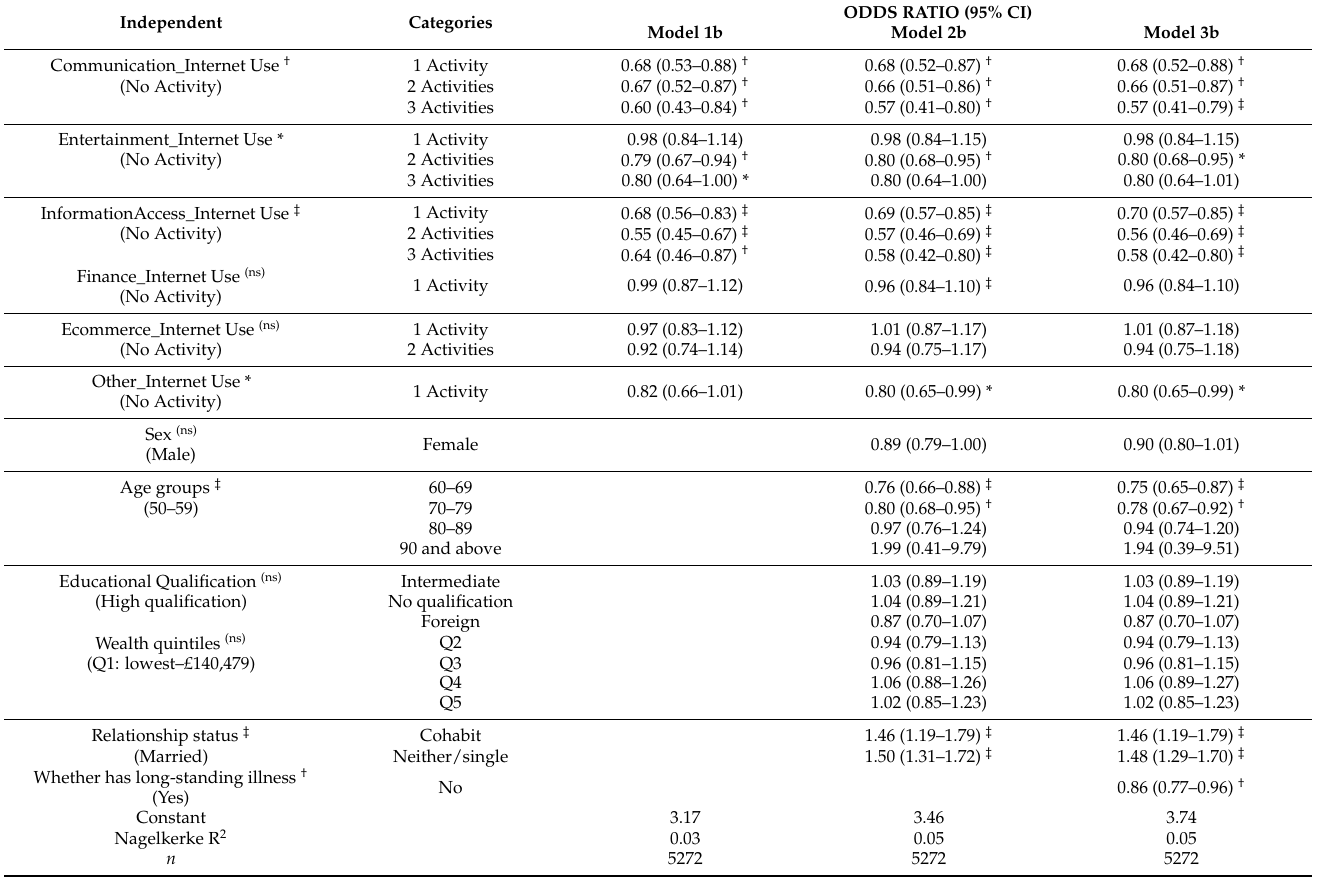
Table 5. Logistic regression results Model